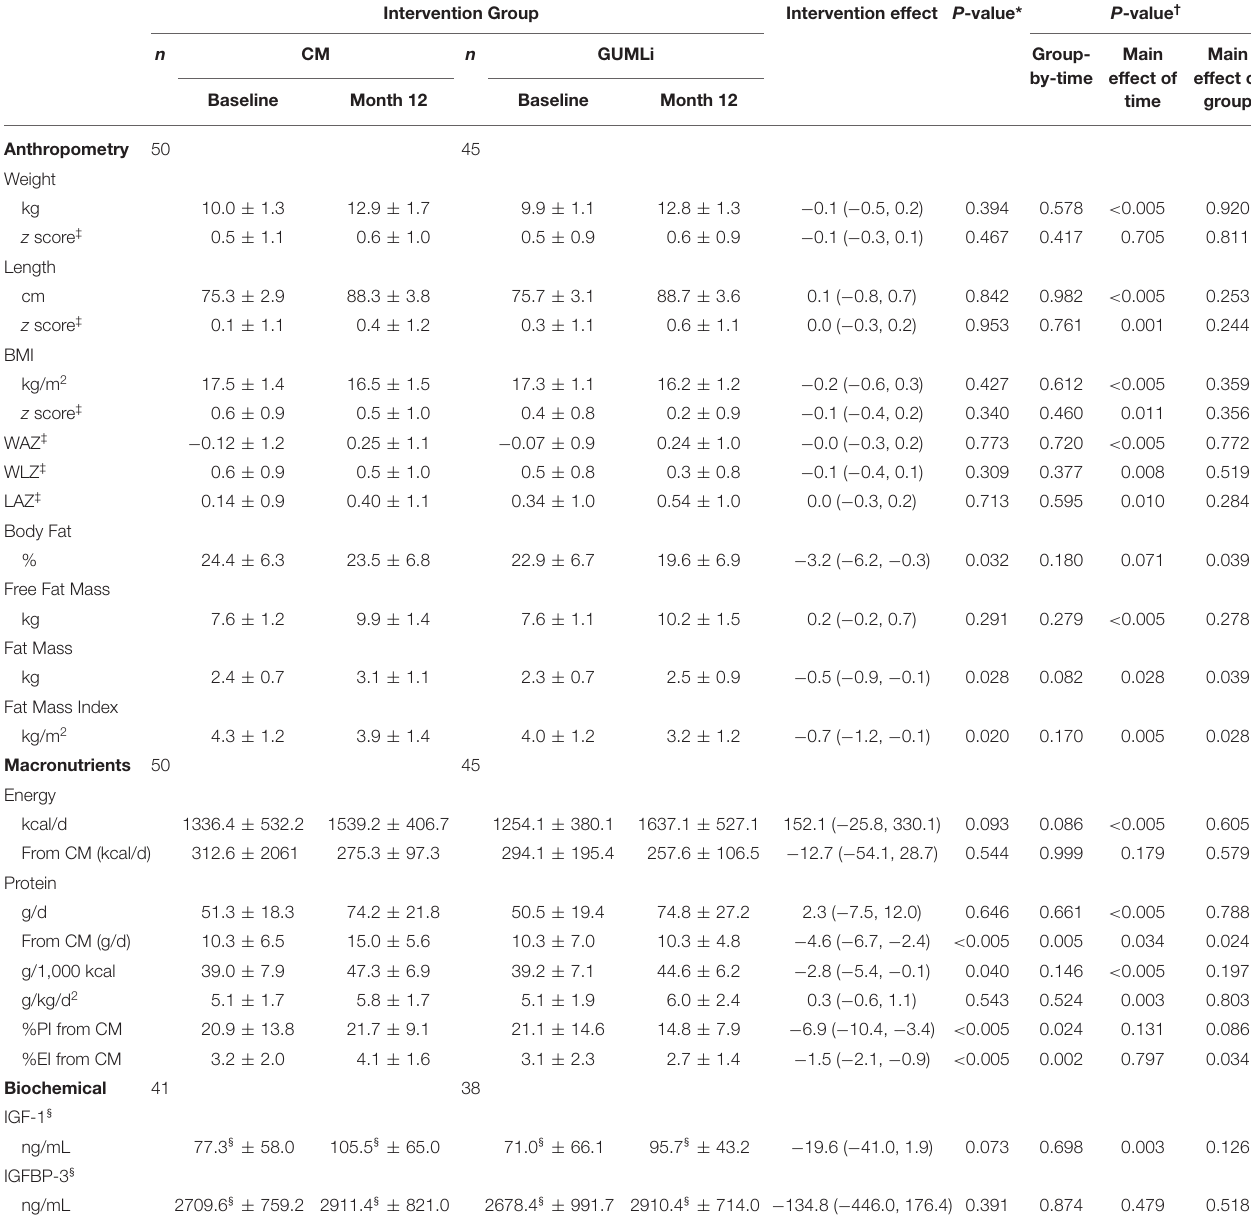
TABLE 2 | Anthropometric, macronutrient, and biochemical outcomes at baseline and month 12 of the intervention and associated treatment effects in a subset of Auckland participants ( n = 79) participating in the GUMLi randomised controlled trial ( N = 160). Intervention Group Intervention effect P -value* P -value † GUMLi Group- Main by-time effect